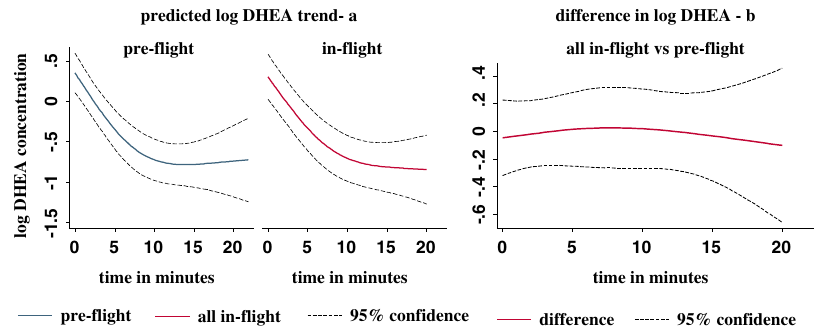
Fig. 6 Predicted mean log DHEA trend and 95% con fi dence intervals for before- fl ight and during- fl ight phases in ( a ). b shows the difference between the two phases as well as the 95% con fi dence